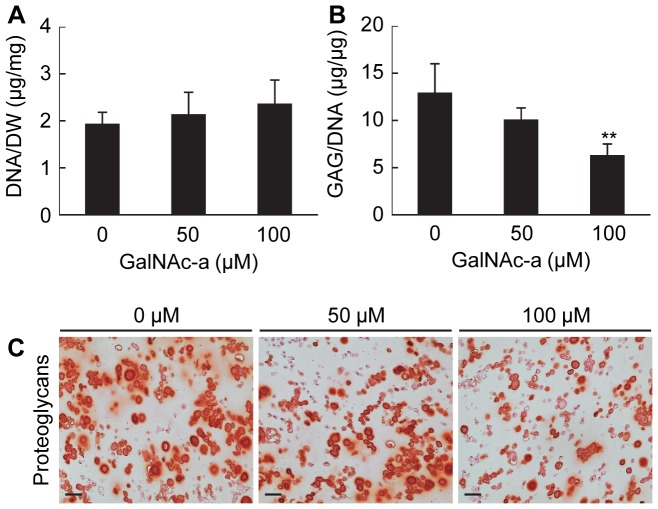
Biochemical analysis of MSCs undergoing chondrogenesis under IL-1β stimulation and GalNAc-a exposure in 3D hydrogels.(A) DNA normalized to construct dry weight and (B) sGAG normalized to DNA content (n = 3, **P<0.01 versus no analog exposure). (C) Histological staining for proteoglycans using Safranin-O (scale bar: 50 µm).